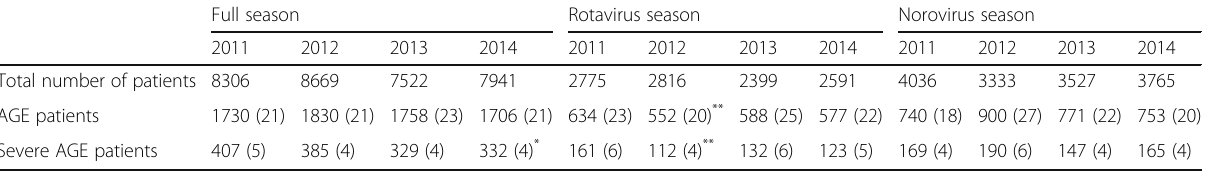
Table 2 Numbers and proportions of AGE and severe AGE patients aged ≥ 6 years